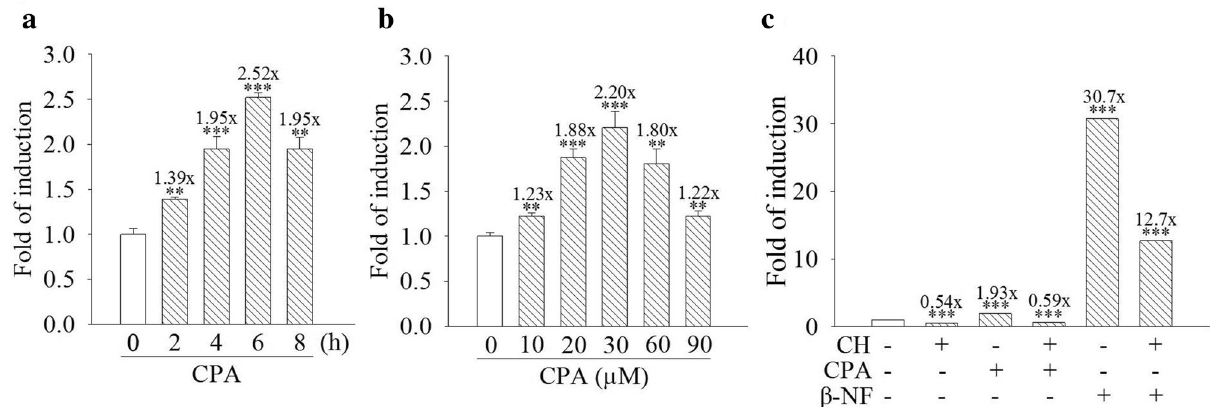
Figure 4. Effect of cyproterone acetate (CPA) on the transactivation activity of the aryl hydrocarbon response element (AHRE) in mouse cells. Reporter plasmids, pAhRDtkLuc3 and RSV- lac Z, were transfected into Hepa- 1c1c7 cells. ( a ) Hepa-1c1c7 cells were treated with CPA (30 μM) for 2–8 h. ( b ) Hepa-1c1c7 cells were treated with CPA (10, 20, 30, 60, and 90 μM) for 6 h. ( c ) Hepa-1c1c7 cells were pretreated with 10 μM CH-223191 (CH) for 1 h, followed by treatment with 30 μM CPA and 1 μM β-NF for 6 h. At the end of incubation with the test compounds, cells were harvested, and cell lysates were collected for an activity assay of luciferase and β-galactosidase. Results are expressed as the mean ± SD, n = 3. ** p < 0.01, and *** p < CYP1A1 expression was revealed by immunofluorescence images (Fig. 3c). BaP-induced CYP1A1 expression was used as a positive control. Cyproterone acetate stimulates transactivation activity of the AhR in mouse cells. To identify cyproterone acetate-induced transactivation activity of the AhR, the pAhRDtkLuc3 reporter plasmid containing three AHRE motifs and the RSV- lac Z reporter plasmid were transfected into the Hepa-1c1c7 cells. Hepa-1c1c7 cells with the reporter plasmids were treated with 30 μM cyproterone acetate for 2–8 h. Cypro- terone acetate increased the transcriptional activity of the AHRE by up to 2.5-fold at 6 h treatment (Fig. 4a). Treatment with cyproterone acetate (10–90 μM) for 6 h dose-dependently induced the transcriptional activity of the AHRE and reached a maximal induction, 2.2-fold, by 30 μM treatment (Fig. 4b). Cyproterone acetate’s induction of CYP1A1 expression is AhR‑dependent. Figure 4a,b show that cyproterone acetate induced the transcriptional activity of AHRE. In order to further examine whether the AhR signal could mediate cyproterone acetate’s induction of CYP1A1 expression, AhR antagonist was applied to block the cyproterone acetate-induced of CYP1A1 expression. CH-223191 is a synthetic AhR antagonist 26 and β-NF is a synthetic AhR agonist, used as a positive control for the induction of AhR activity. Both cyproter- one acetate and β-NF increased the transcriptional activity of the AHRE, but their inductions were blocked by CH-223191 (Fig. 4c). When cells were treated with cyproterone acetate together with CH-223191, both cypro- terone acetate-induced CYP1A1 mRNA and protein expressions were highly suppressed in Hepa-1c1c7 cells (Fig. 5a,b). In addition, AhR signal-deficient Hepa-1c1c7-derivative cells, c4 and c12, were applied. CYP1A1 expression was highly induced by cyproterone acetate in Hepa-1c1c7 cells, but not in c4 and c12 cells (Fig. 5c). To analyze whether the AhR was activated by cyproterone acetate, nuclear localization of the AhR was monitored by an immunofluorescence image. The AhR translocated to the nucleus when Hepa-1c1c7 cells were treated with cyproterone acetate (30, 60, and 90 μM) and β-NF (10 μM) for 2 h (Fig. 6). β-NF is a synthetic AhR agonist 22 and the β-NF-induced nuclear localization of AhR was used as a positive control. The location of the nucleus was revealed by the fluorescence dye, Hoechst 33,342. Cyproterone acetate suppresses CYP1A1 mRNA expression and the AhR ligand‑induced CYP1A1 protein expression in human cells. Treatment with cyproterone acetate suppressed CYP1A1 mRNA expression with time course- and dose-dependency in HepG2 and MCF7 cells. The maximal suppression of CYP1A1 mRNA expression was detected at 8 and 6 h of treatment with cyproterone acetate (10 μM) in HepG2 and MCF7 cells respectively, and thereafter, the extent of suppression effect was decreased (Fig. 7a,b). Treatment of cyproterone acetate (20 and 10 μM) for 6 h in HepG2 and MCF7 cells respectively caused the maximal sup- pression of CYP1A1 mRNA expression (Fig. 7c,d), and treatment with higher doses of cyproterone acetate did not cause further suppression. Treatment with 30 μM cyproterone acetate for 3–7 h did not distinctly increase CYP1A1 protein expression in HepG2 cells (Fig. 7e). Treatment with 10–90 μM cyproterone acetate for 5 h also did not distinctly increase CYP1A1 protein expression in HepG2 cells (Fig. 7f). ITE is an endogenous AhR ligand, and β-naphthoflavone (β-NF) is a synthetic AhR ligand. Co-treatment of 30–60 μM cyproterone acetate with either 1 μM ITE or 10 μM β-NF reduced both ITE- and β-NF-induced CYP1A1 protein expression (Fig. 7g,h).